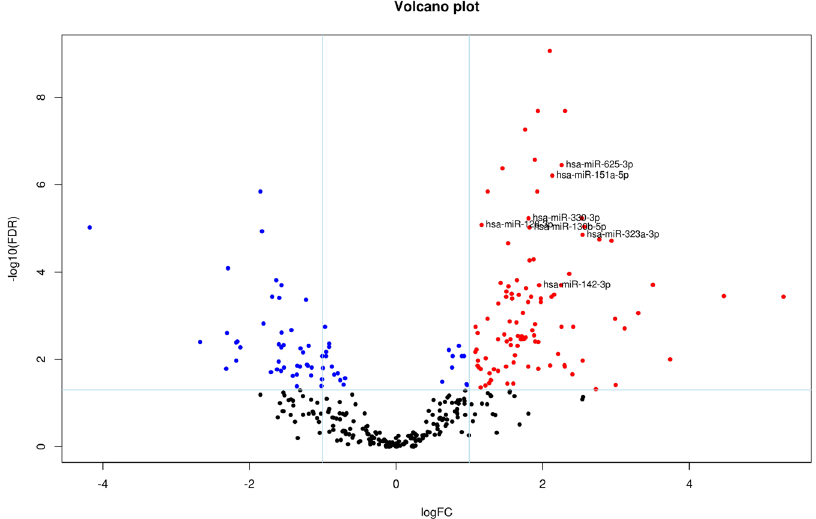
Figure 1. Volcano plot of differentially expressed human mature miRNAs in patients versus controls. Vertical lines indicate the threshold for a relative expression fold change (FC) of 2 or - 2 fold compared to controls. The horizontal line represents the threshold of a 0.05 FDR value. The red and blue points lying in the top right and top left sectors are significantly upregulated and downregulated, respectively, in patient versus control samples (FDR < 0.05, FC ≥ 2 or ≤ - 2). miRNAs selected by LASSO and cross validation are